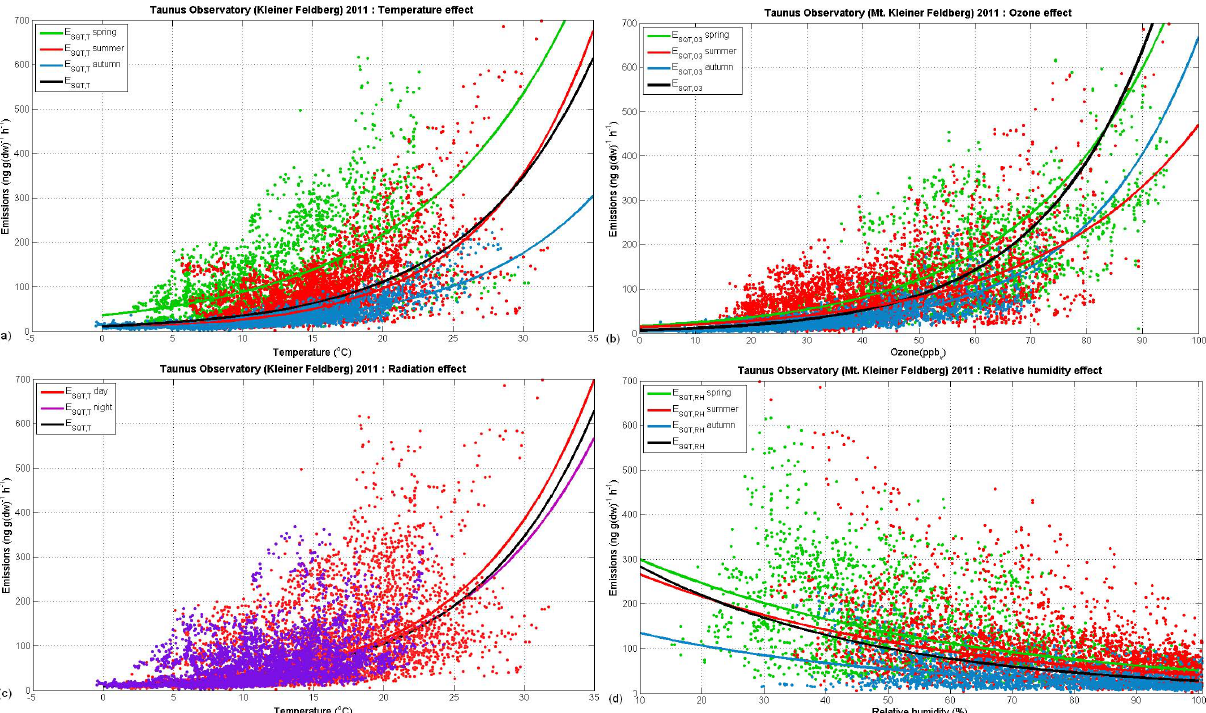
Fig. 1. SQT emission responses to different stress factors. (a) (temperature): E SQT ,T = (347.2 ± 70.4) ngg(dw) − 1 h − 1